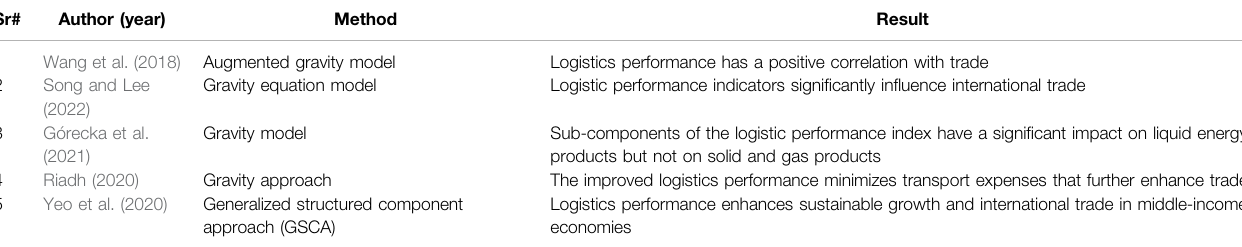
TABLE 1 | Recent evidence on logistics performance and